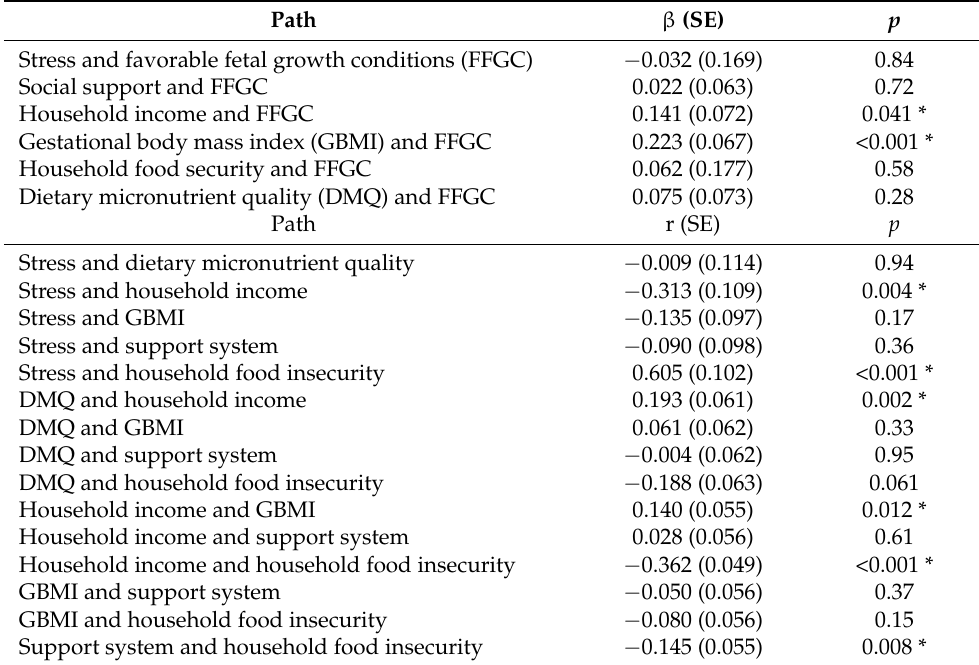
Table 5. Associations within the structural equation model/Hypothesis